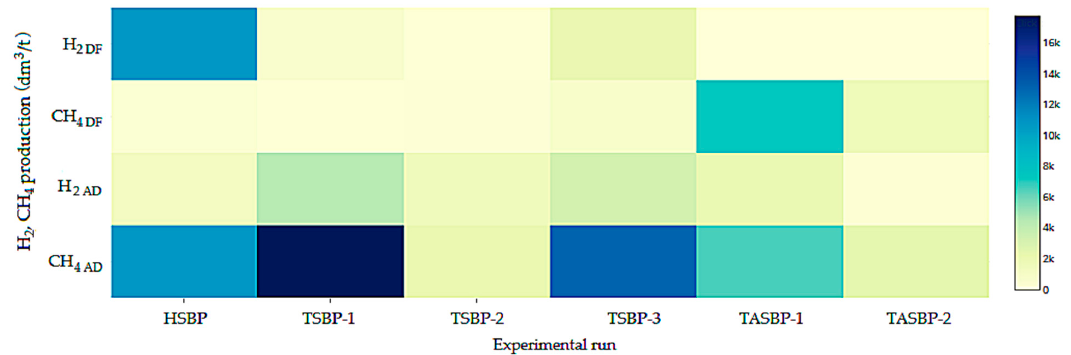
Figure 4. Heat map produced using data from mass balance. The columns of the heat map represent hydrolysates and the rows represent H 2 and CH 4 production (CH 4AD , H 2AD —without pretreatment; CH 4DF , H 2DF —with pretreatment). Each cell is colorized based on the level of gas volume from 1 t of